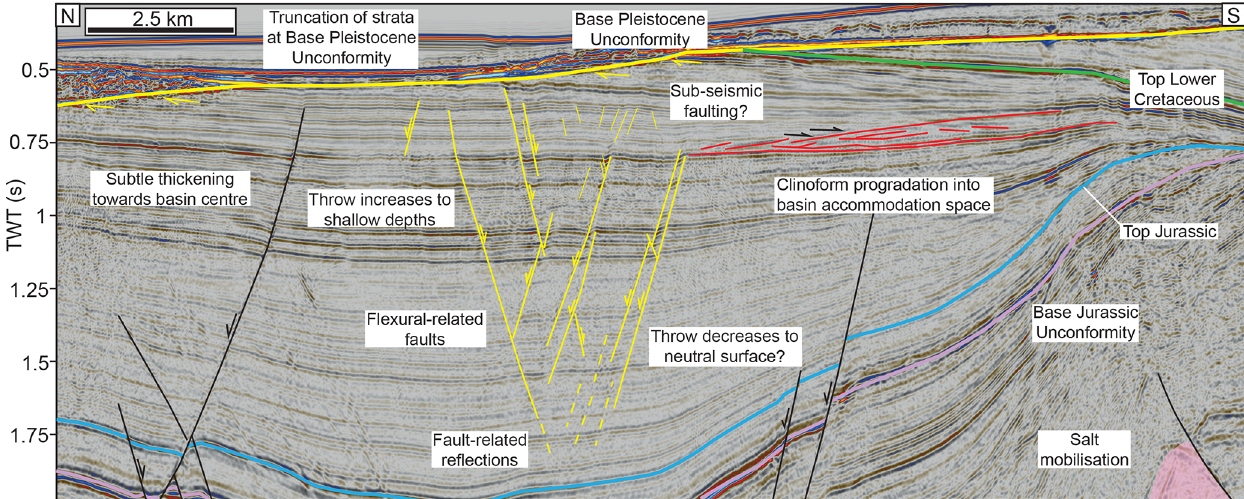
Figure 10. Interpreted seismic section across the centre of the Farsund Basin. See Fig. 2 for location. Lower and Upper Cretaceous strata are truncated at the base Pleistocene unconformity, and a series of low-displacement faults are developed in the centre of the